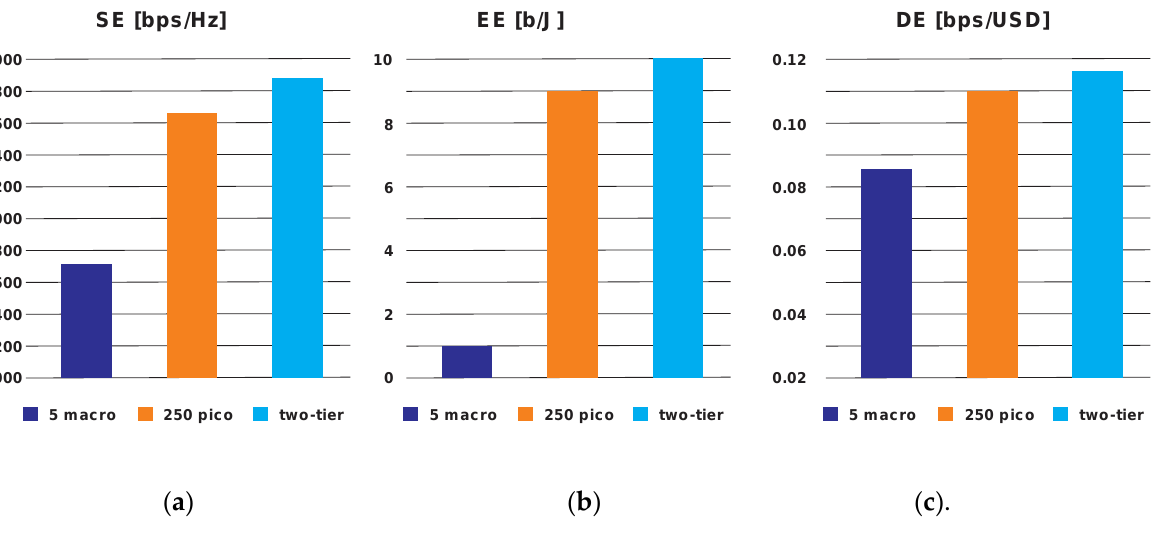
Figure 4. Simulation results: ( a ) SE, ( b ) EE, ( c ) DE.